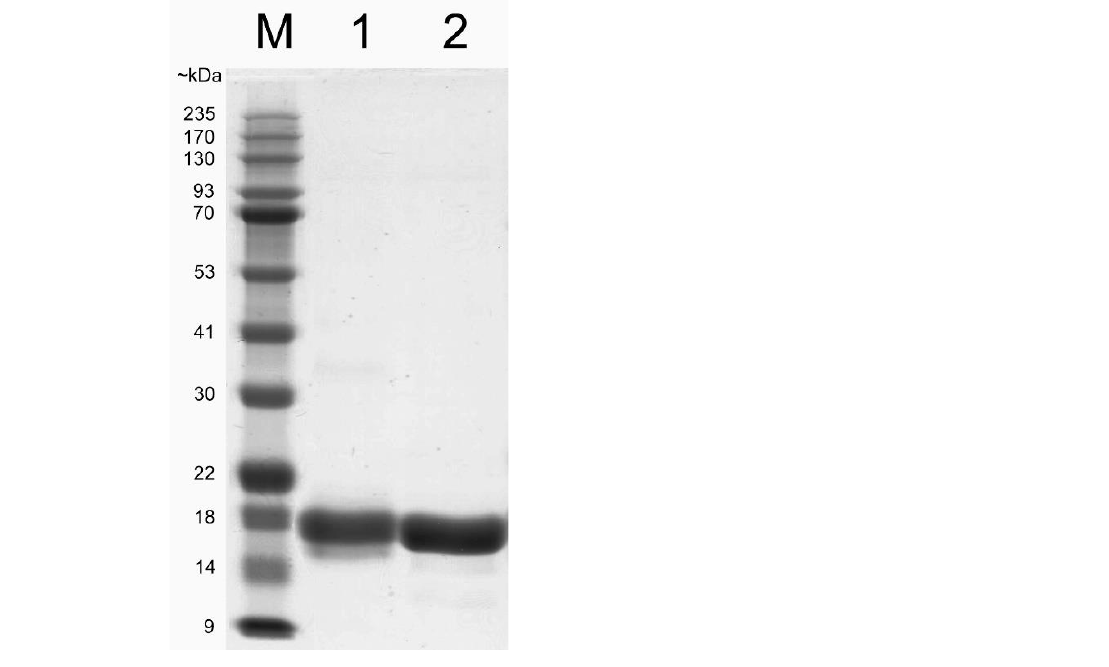
Figure 3. Coomassie blue straining SDS-PAGE of purified recombinant Imp-PM19 and ∆ D3-Imp- PM19 mutant. His-tagged Imp-PM19 and ∆D3 -Imp-PM19 -mutant were expressed recombinantly in E. coli . The proteins were purified using Ni-NTA fast flow column. M is a protein marker. Lane 1 and 2 are purified Imp-PM19- His and ∆D3 -Imp-PM19-His, respectively.